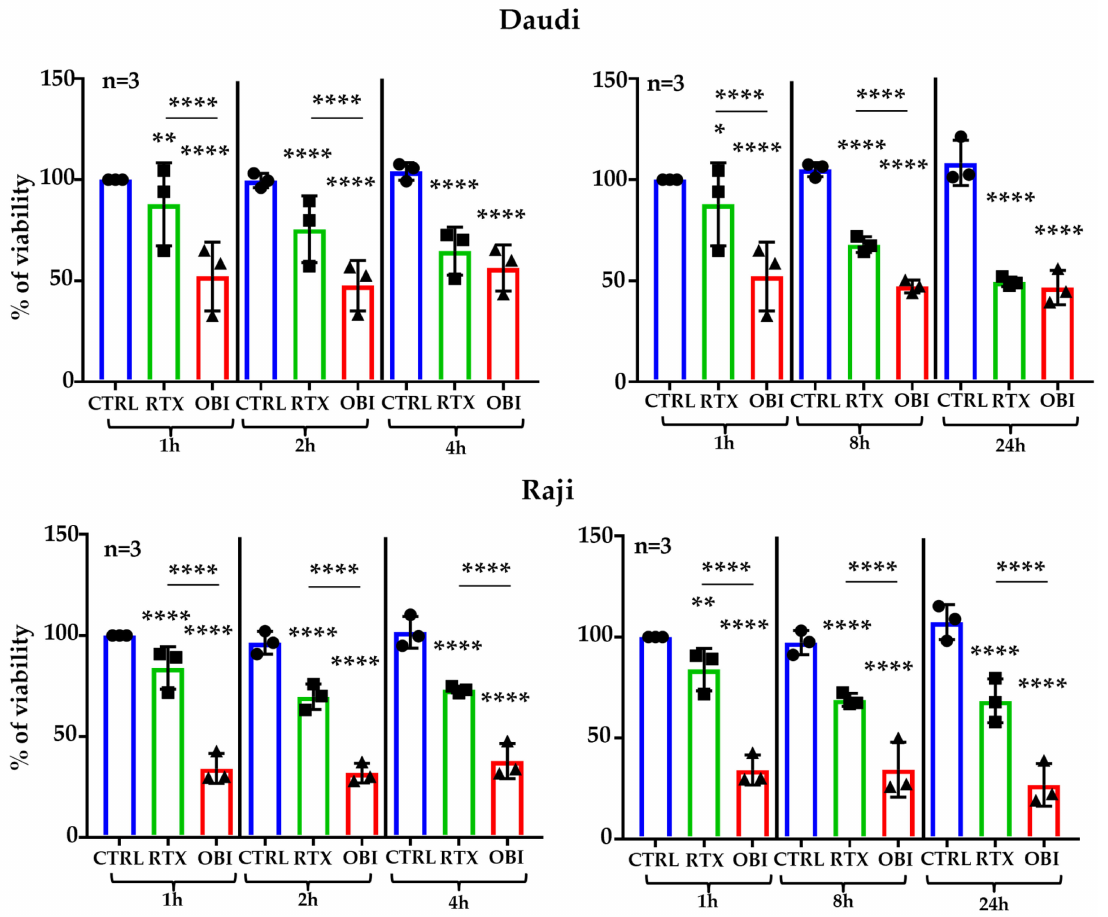
Figure 1. RTX and OBI induce quick direct cell death measured by Muse ® Cell Analyzer. The depicted cell lines (1 million/mL) were incubated with RTX or OBI (10 µ g/mL) for the indicated times. Next, cells were incubated with the Muse TM Count & Viability Assay kit and cell viability was directly analyzed in a Muse ® Cell Analyzer. The graphs display the percentage of viability after normalizing the viability at time 0 to 100%. The graphs display the mean ± SD of 3 independent experiments with biological replicates; * p < 0.05, ** p < 0.01, **** p < 0.0001; Tukey’s multiple comparisons test compared to control or as depicted in the